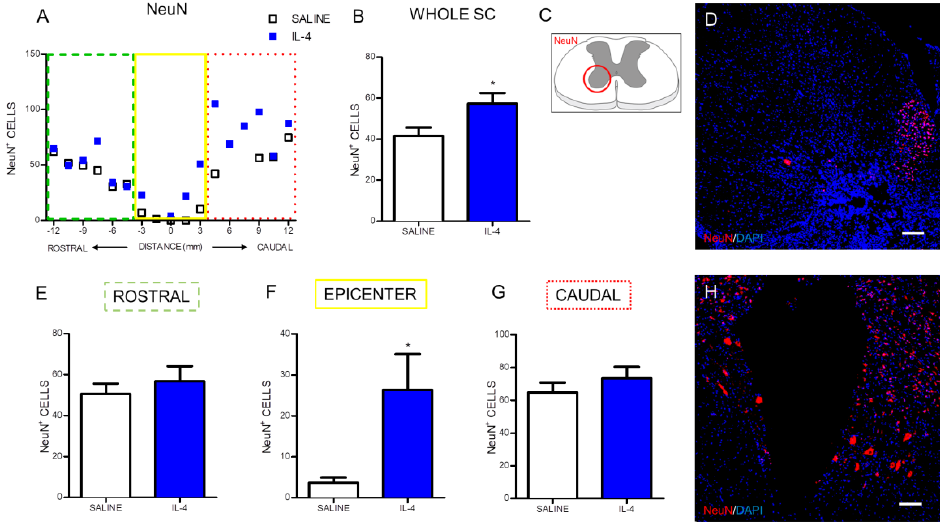
Figure 5. IL-4 treatment increases the number of motor neurons in the ventral horns. Distribution of the NeuN + cells along the rostrocaudal axis of the spinal cord ( A ); Quantification of NeuN + cells in the whole spinal cord revealed a significant increase of motor neurons in IL-4-treated rats ( B ); A significant increase of motor neurons was also observed at the epicenter region of the spinal cord ( F ); while in the rostral ( E ) and at the caudal ( G ) areas no differences could be observed. Schematic image indicating areas where the analyses were performed ( C ); Representative images of positive staining for motor neurons of saline ( D ) and IL-4 treated ( H ) group. Values shown as mean ± SEM. * p < 0.05. Scale bar = 100 µm.